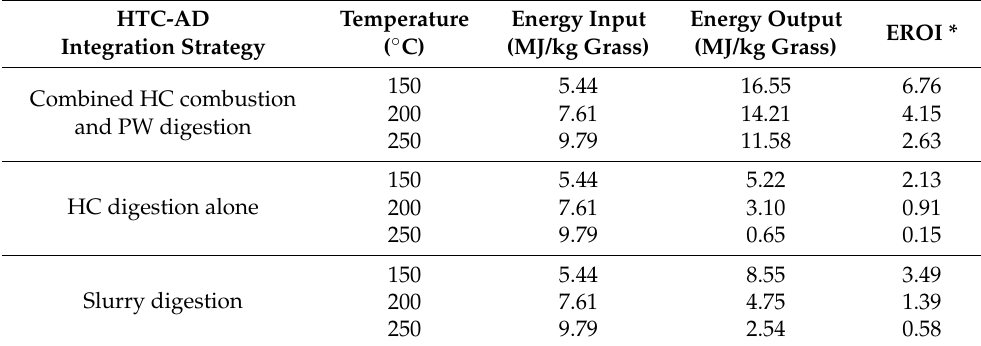
Figure 6. Energetic output of HTC-AD integration strategies: ( a ) combustion of hydrochar and digestion of process waters, ( b ) digestion of hydrochars only, and ( c ) digestion of HTC slurries, all based on 1 kg of oven dried grass. Percentages above the bars represent the energy conversion efficiency (ECE) of each integration strategy. Table 7. Energy balance for HTC-AD integration strategies based on 1 kg oven dried